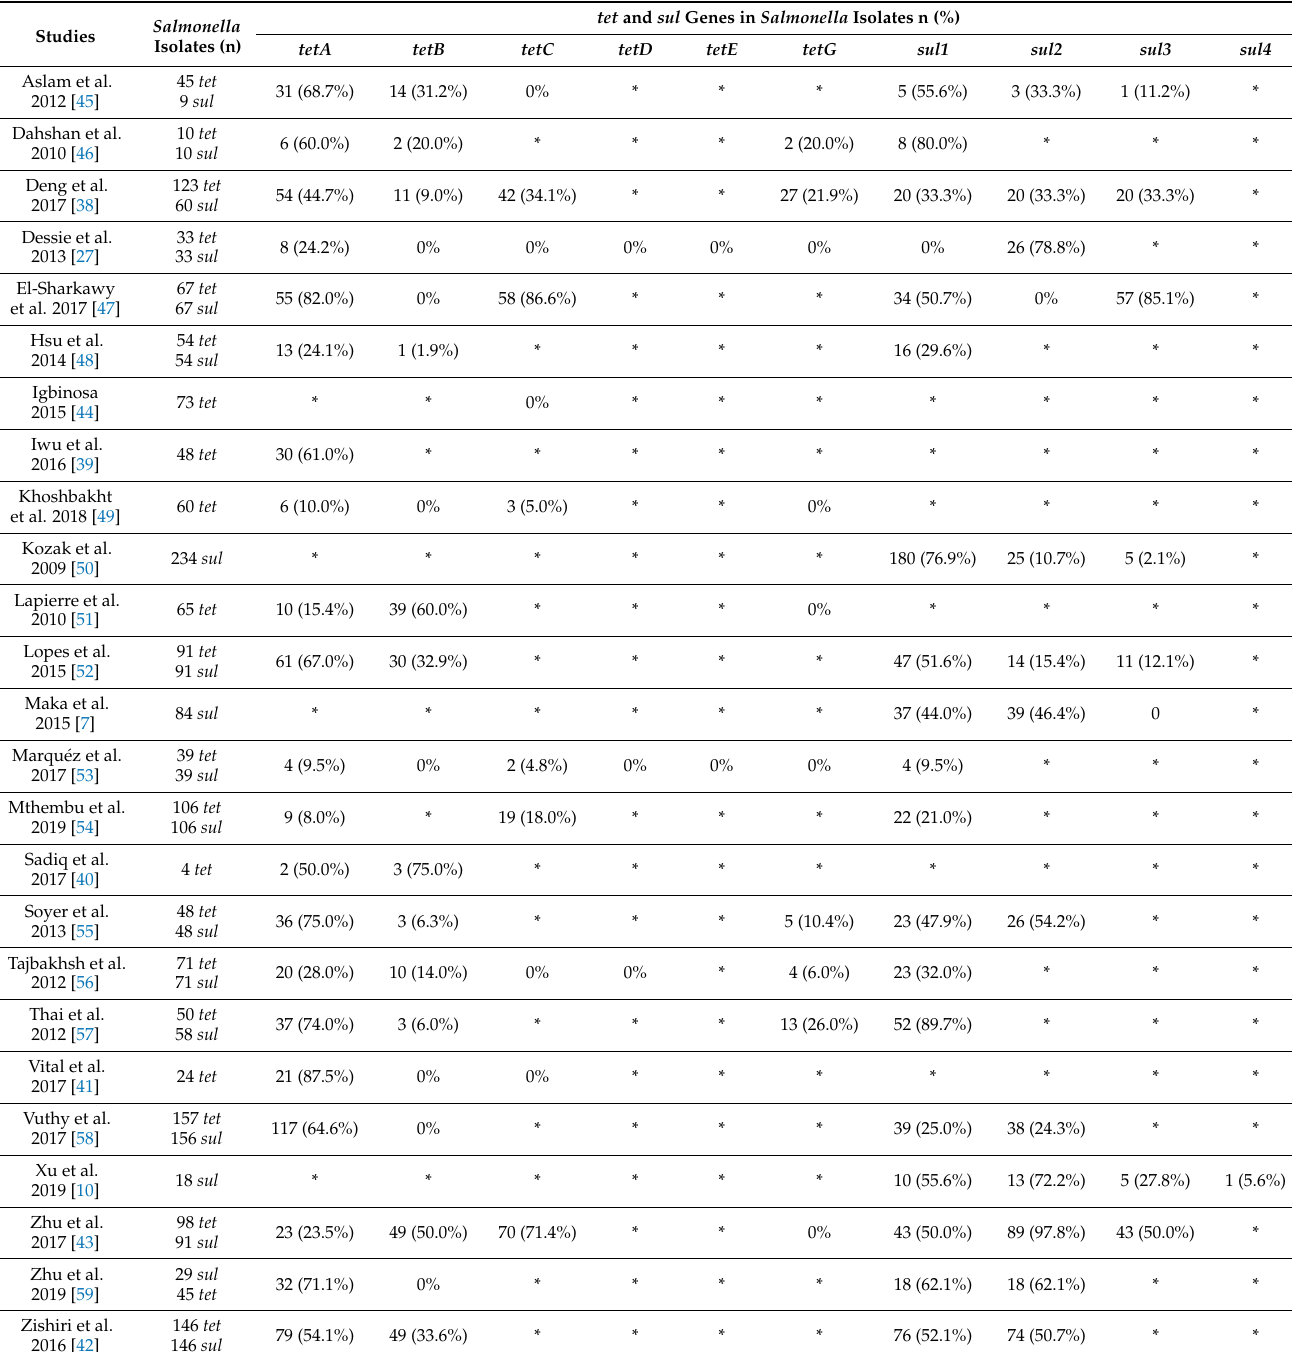
Table 3. Distribution of tetracycline and sulfonamide resistance genes in relation to Salmonella isolates